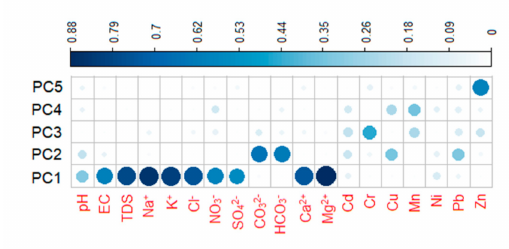
Figure 9. Quality representation of the variables on the factor